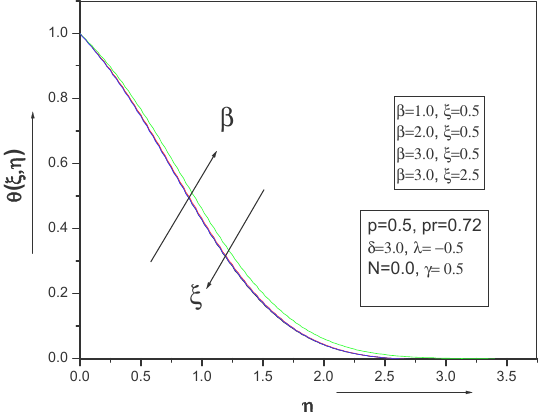
Figure 3. Effect of the magnetic force parameter on temperature profile.